Question: What does this figure show? Answer in one sentence.
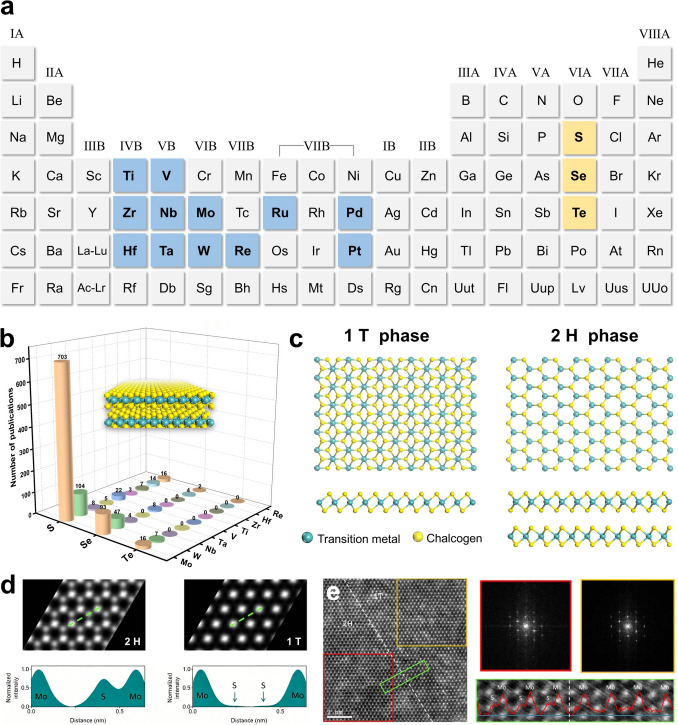
Answer: a Anion and cation element composition of layered TMDs; b number of publications of TMDs-based EMA materials with various element configurations (data collected from Web of Science); c atomic structure of TMDs in their typical 1T and 2H phase; d simulated HAADF-STEM images of ideal 2H-MoS 2 and 1T-MoS 2 phases. The bright spots correspond to Mo atoms; e STEM image of a region where a boundary between 2H and 1T phases and corresponding Fourier transform images (right top) and the intensity profile along the green region (right bottom) [ 72 ]. Copyright 2012 American Chemical Society